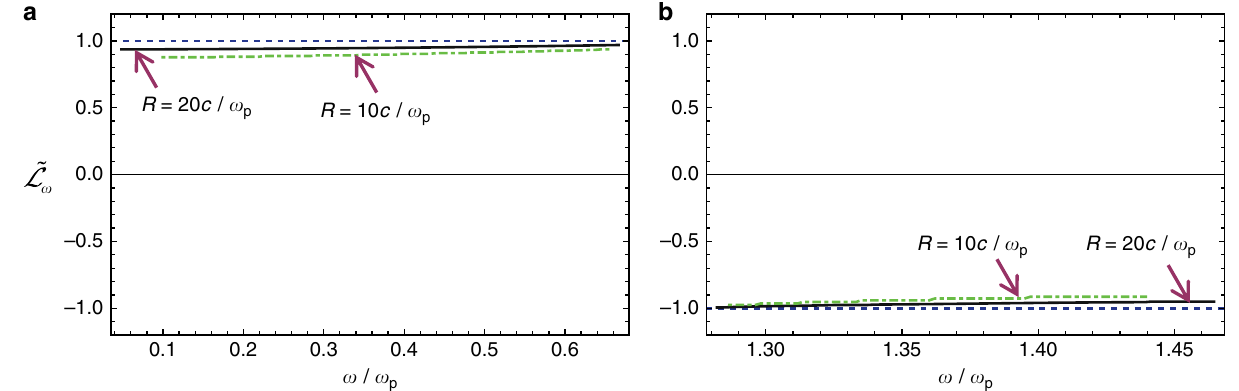
Fig. 4 Angular momentum spectral density as a function of frequency. The normalized angular momentum spectral density ~ L ω is depicted for ( a ) the 1st band gap and ( b ) for the 2nd band gap for a cylindrical cavity with radius R ¼ 10 c = ω angular momentum density becomes quantized (blue dashed horizontal line). The cyclotron frequency is ω